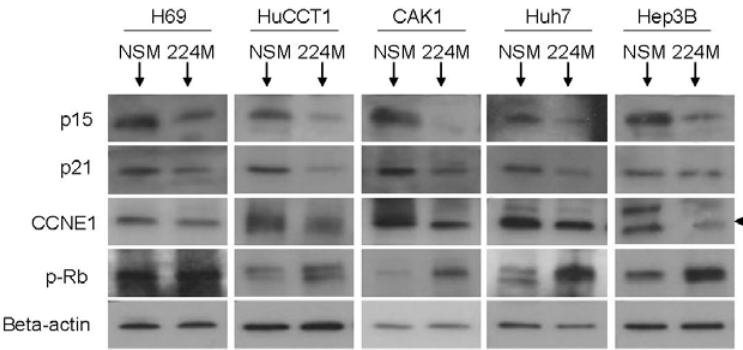
Figure 5. Protein expression of miR-224 target genes decrease upon miR-224 stimulation. Representative Western blots for p15, p21, CCNE1, and phospho-Rb are shown. The arrow indicates the predicted molecular size of CCNE1 of 53 kDa. Equal protein loading is shown by probing against